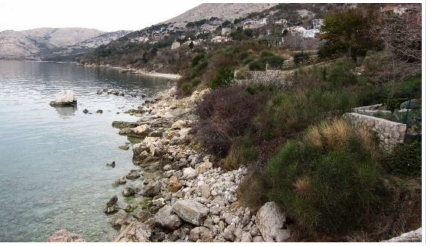
Figure 8. Landslide toe before the building of retaining wall.